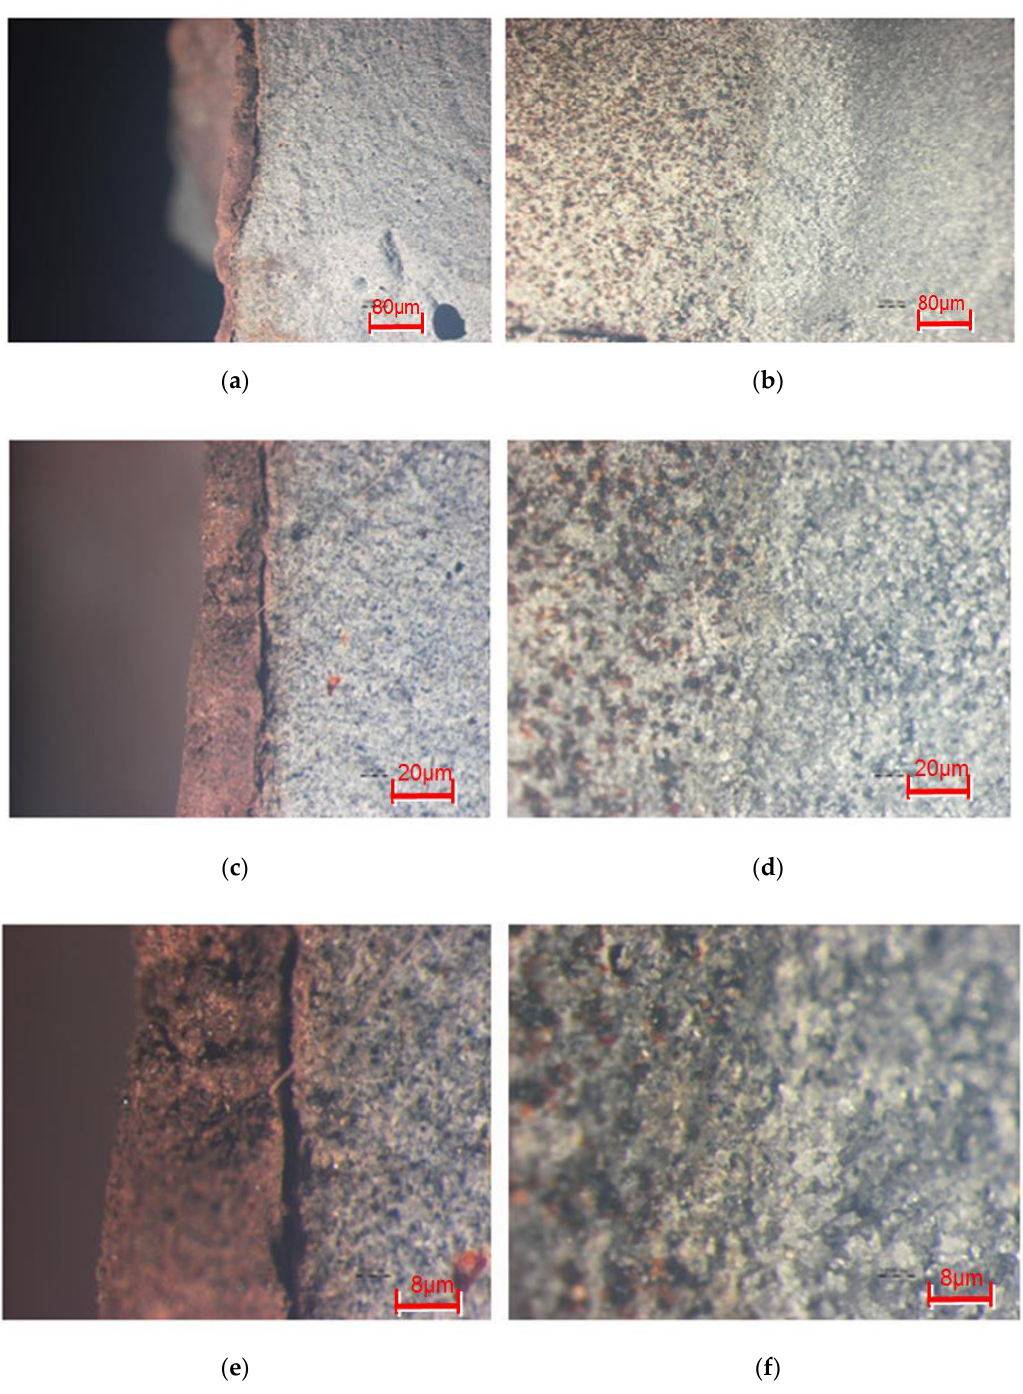
Figure 16. Microscopic cementation figure of cement stone with undrained core and clean core. ( a , c , e ) are adhesion of drilling fluid core to cement stone; ( b , d , f ) are clean core to cement stone